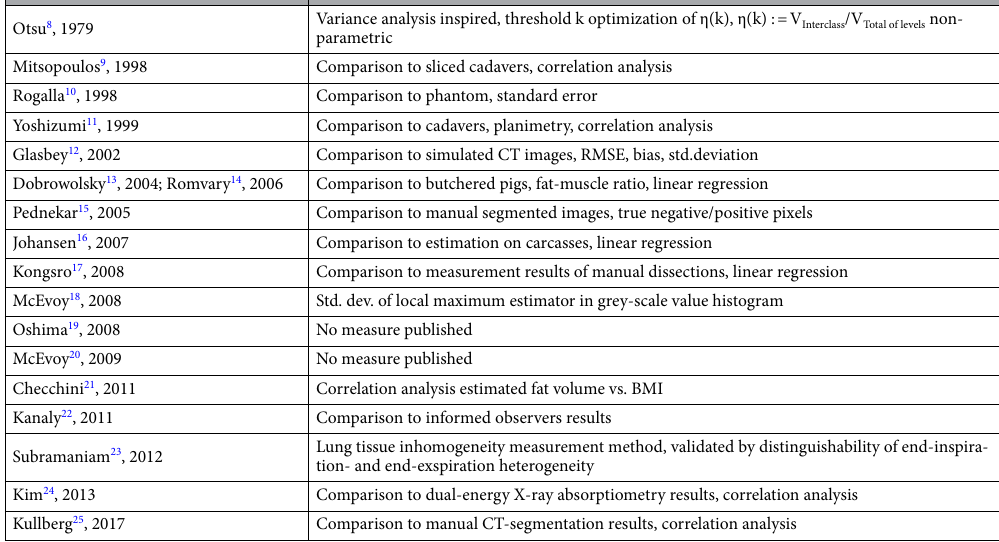
Table 2. Studies in literature about CT fat segmentation: quality